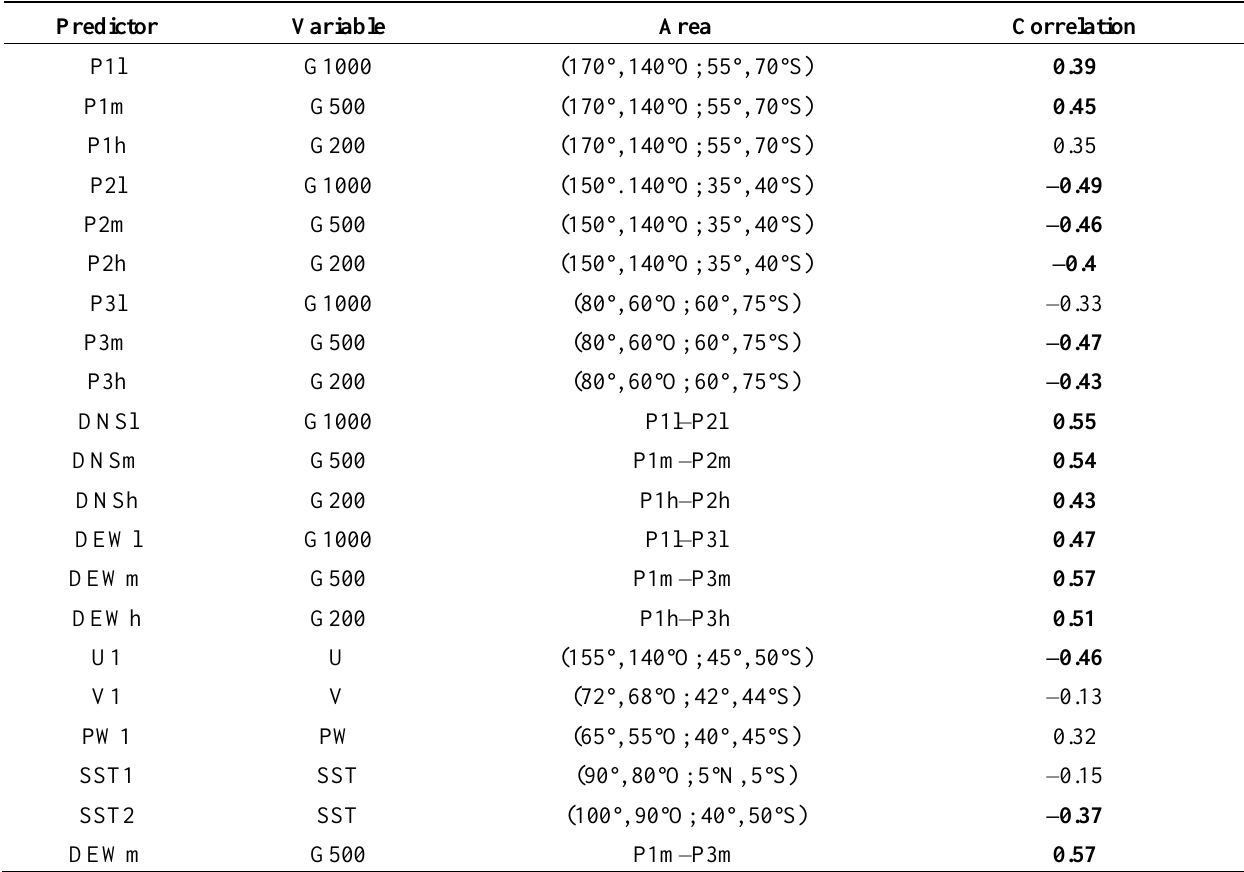
Table 2. Predictors defined using difference between dry and wet composites fields (*). Correlations greater than 0.37 are significant at 95% confidence level ( bold